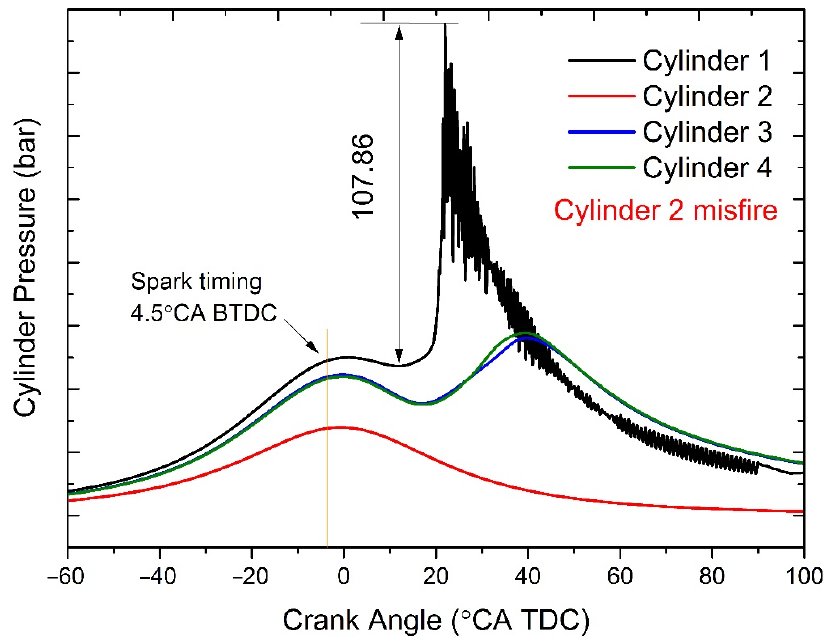
Figure 9. Super ‐ knock in the next ignition cylinder corresponding to the misfired cylinder. Figure 9. Super-knock in the next ignition cylinder corresponding to the misfired